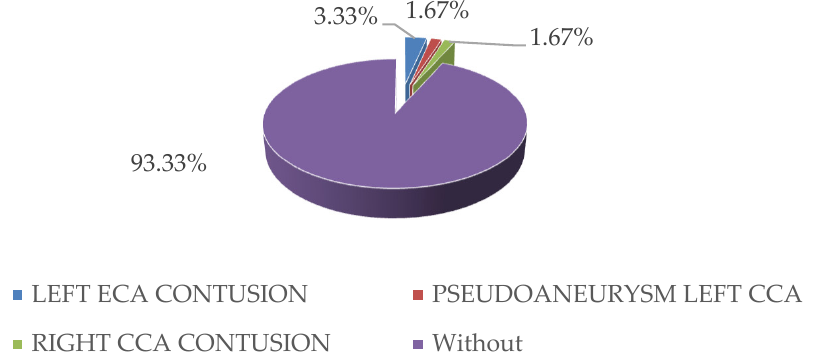
Figure 2. Distribution of venous lesions that required surgical treatment. (AJV = anterior jugular vein, IVJ = internal jugular vein, EJV = external jugular vein).